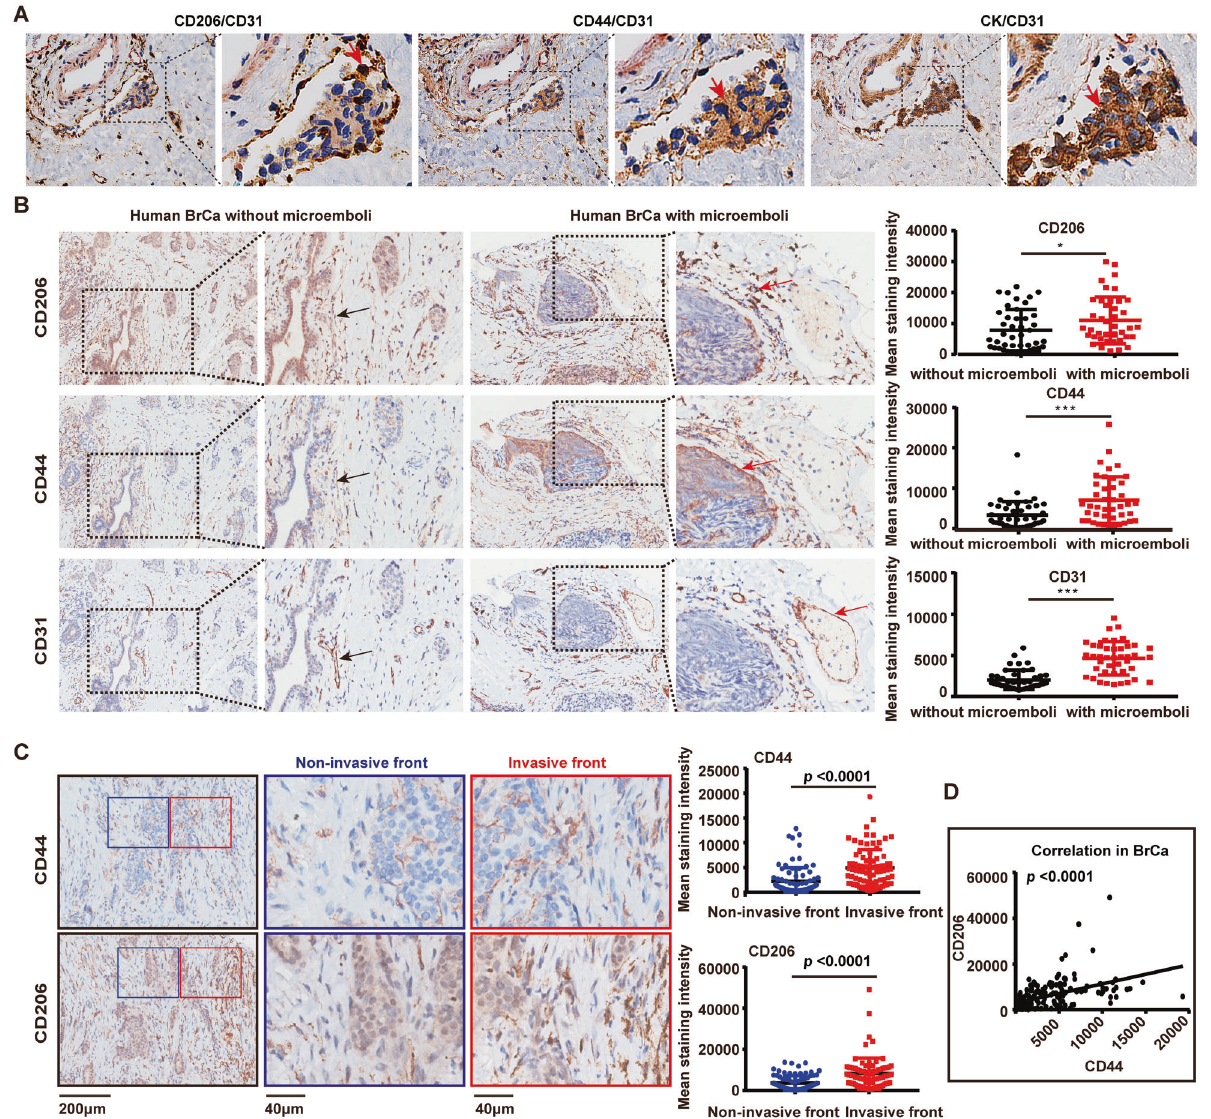
Fig. 1 CD44 high cancer cells and TAMs co-localized in microemboli of vessels and at invading edges of human BrCa tissues. A Representative images of cell clusters in the vasculature of human primary breast tumor. The distributions of CD206 (brown), CD44 (brown), CK (brown), and CD31 (red, indicating vessels) in tissue serial sections from luminal-like BrCa ( n = 15) were determined by immunohistochemical staining. Nuclei are stained with hematoxylin. B Immunohistochemical staining of CD206, CD44, and CD31 was performed in serial tissue sections of human BrCa. Tumors with and without microemboli from a tissue microarray (85 human breast lesions) were analyzed. Using Image-Pro Plus software, the expression intensity of each molecule was evaluated by integral optical density and compared with and without microemboli. Data were analyzed with the Mann-Whitney test. * p < 0.05, *** p < 0.001. C The expression of CD44 and CD206 in the invasion front versus non-invasive front of serial sections from human BrCa tissues was analyzed. Data represents the